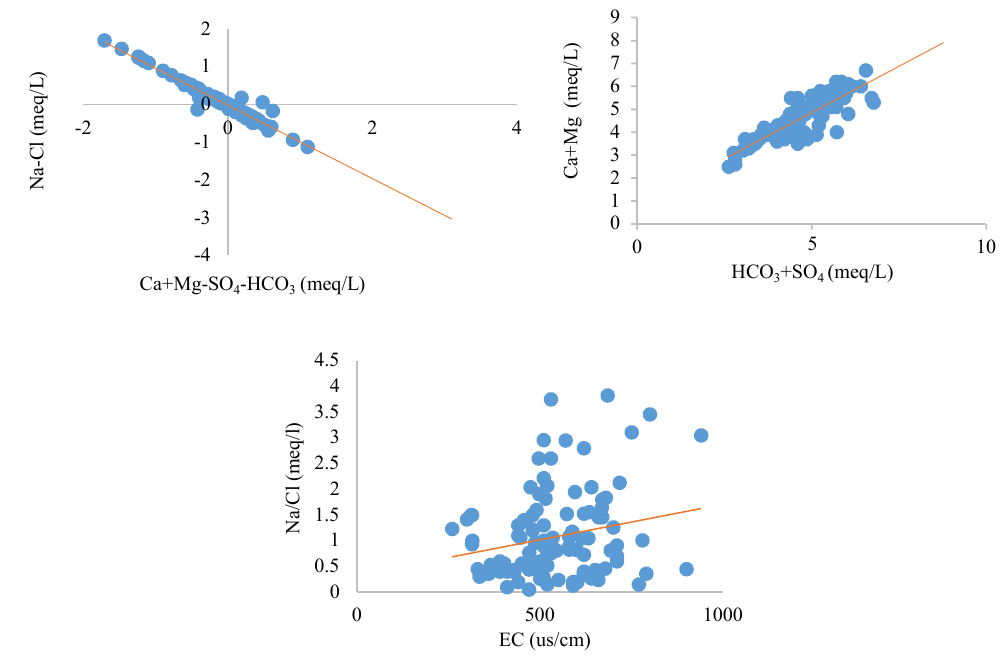
Fig. 5. Two-variable diagrams of ions